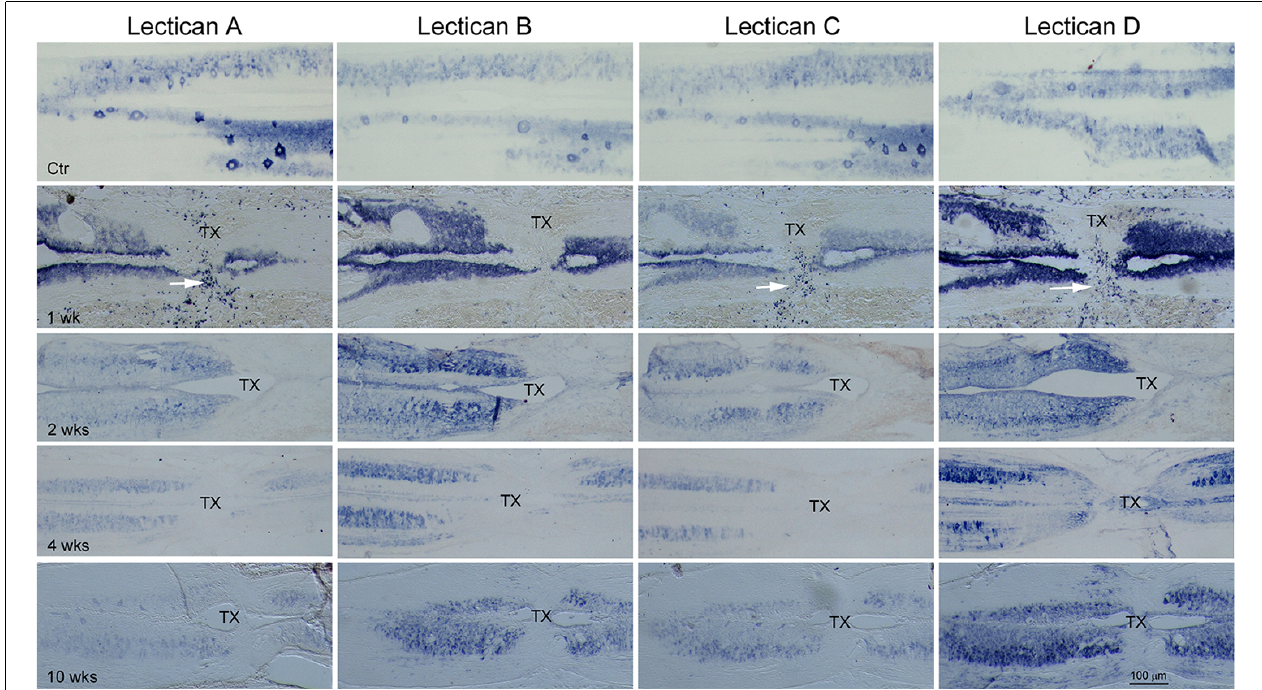
FIGURE 7 | The expression of lecticans after SC-TX. ISH using probes LecA, LecB, LecC, and LecD, individually, performed on horizontal sections of non-injured (Ctr) or injured animals spanning a TX-site mounted alternately on four slides as described in Figure 6 . After SC-TX, robust upregulation of lecticans B and D causes them to predominate over lecticans A and C, which dominated before TX. Upregulation of lectican D, in particular, persisted at least 10 weeks post-TX. Many small cells in the TX site are densely labeled by LecA, LecC, and LecD, but not by LecB, at 1 week post-TX (white arrows). IB4-HRP staining identifies only a few of these small cells as microglia/macrophages (see Figure 9 ). These results suggest that lecticans B and D may play important roles after SC injury. TX = transection